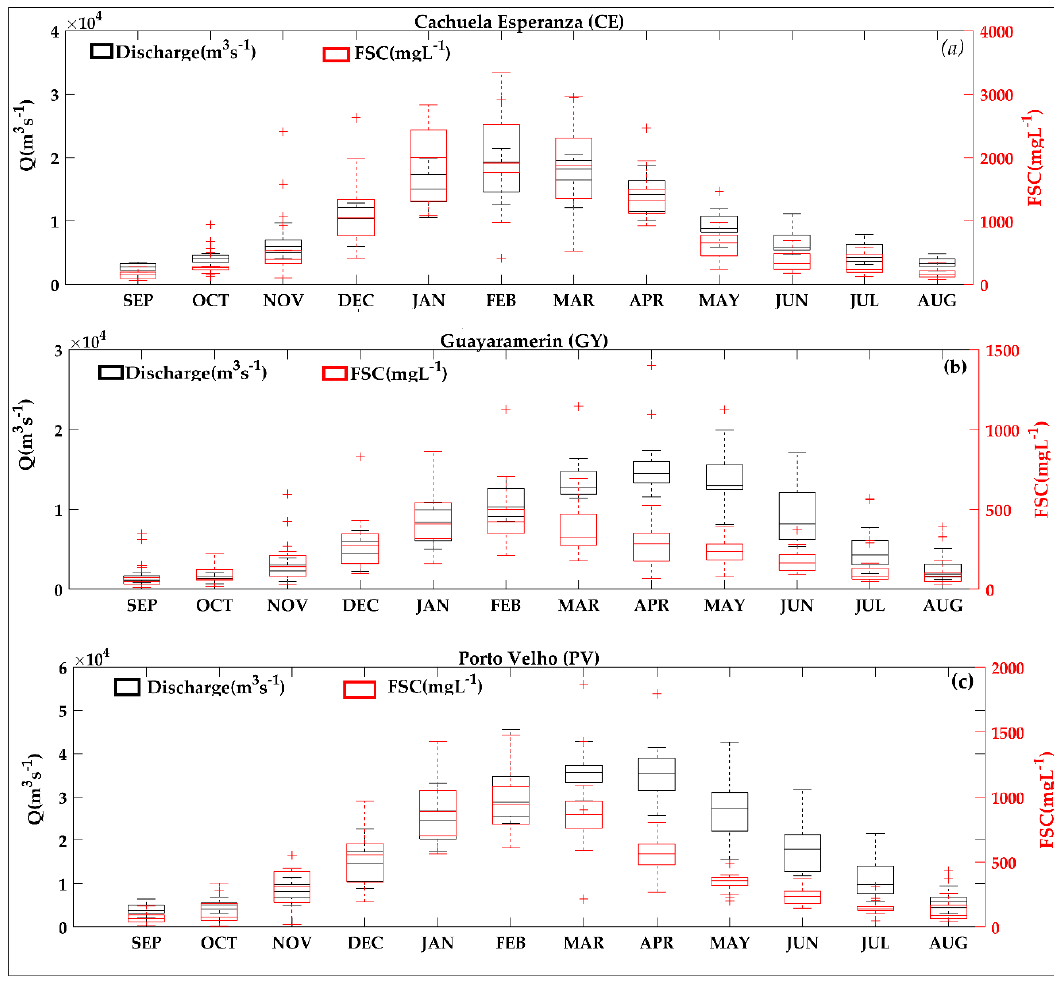
Figure 2. Monthly discharge (Q) in m 3 · s − 1 and monthly fine suspended sediments (FSC) in mg · L − 1 ( a ) at Cachuela Esperanza (CE) in the Beni River, ( b ) at Guyaramerin (GY) in the Mamoré River, ( c ) and at Porto Velho (PV) in the Madeira River. Note that the y-axes have different ranges according to the station.